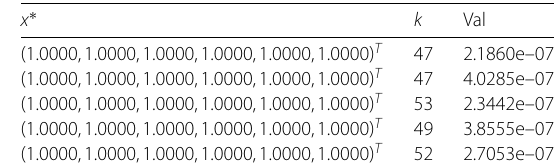
Table 2 Numerical results for Example 4.2